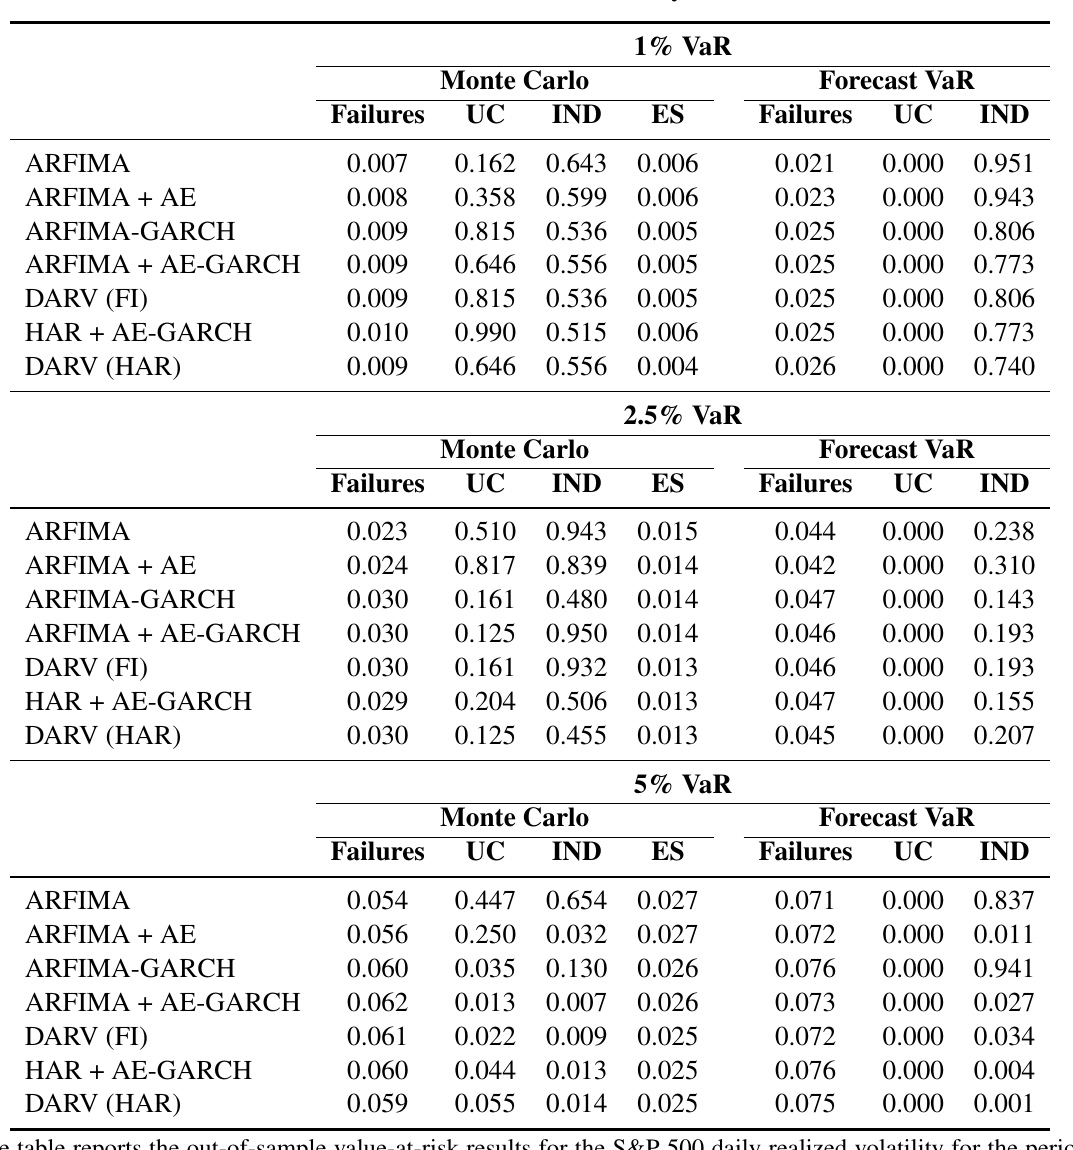
Table 12. Value-at-risk